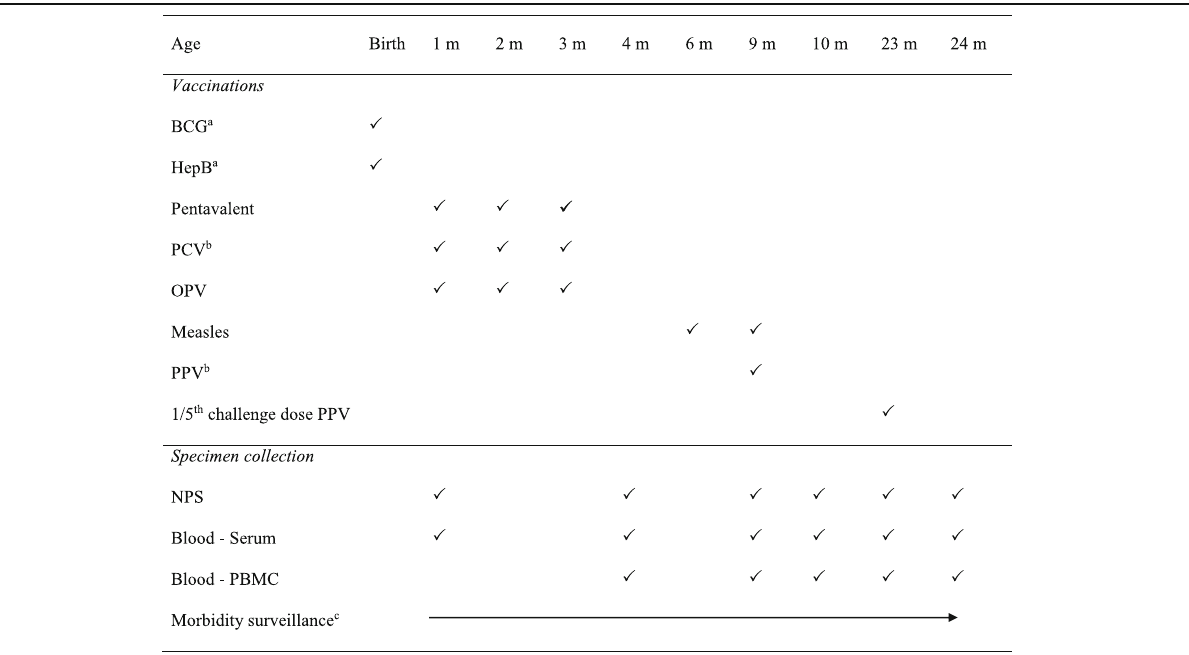
Table 1 Vaccination and specimen collection